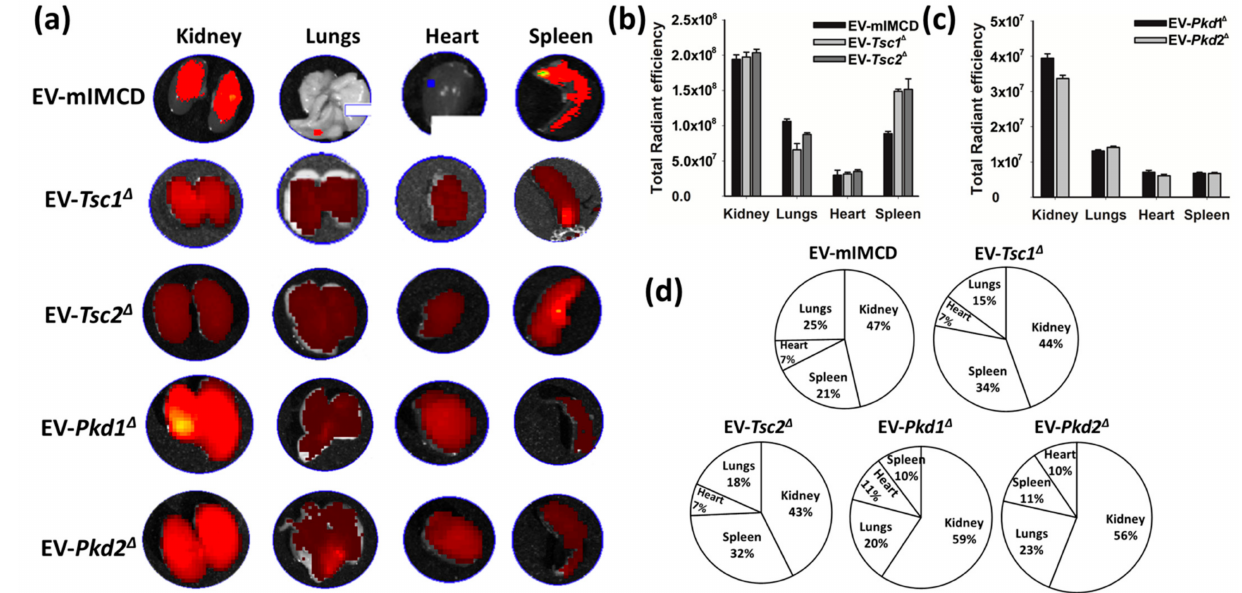
Figure 4. Ex vivo tissue distribution of Dir-labelled extracellular vesicles derived from cell lines; 1.67 × 10 9 EV per kilogram body weight were intraperitoneally injected for four hours followed by tissues excision and imaged using a Perkin Elmer imaging system. ( a ) Imaging reveals the migration of EV to the kidneys, lungs, heart, and spleen. The EVs were isolated from the following cell lines: T1G ( Tsc1 deleted), T2J ( Tsc2 deleted), PKD1 ( Pkd1 deleted), and PKD2 ( Pkd2 deleted). ( b , c ) Representation of average radiant efficiency in different organs (kidney, lungs, heart, and spleen) after introduction of EVs purified from conditioned medium of different cell lines. ( d ) Representation of migration of various EVs in different organs. Note: Images were captured using an IVIs Perkin Elmer imaging system. The images were captured under the same instrumental settings, i.e., excitation: 750 nm, exposure time: 1000 ms, emission wavelength: 780 nm. Each image was captured under the same color scale (min = 1.00 × 10 8 ; max = 1.00 × 10 9 ). The data presented here is the average total radiant efficiency in the respective